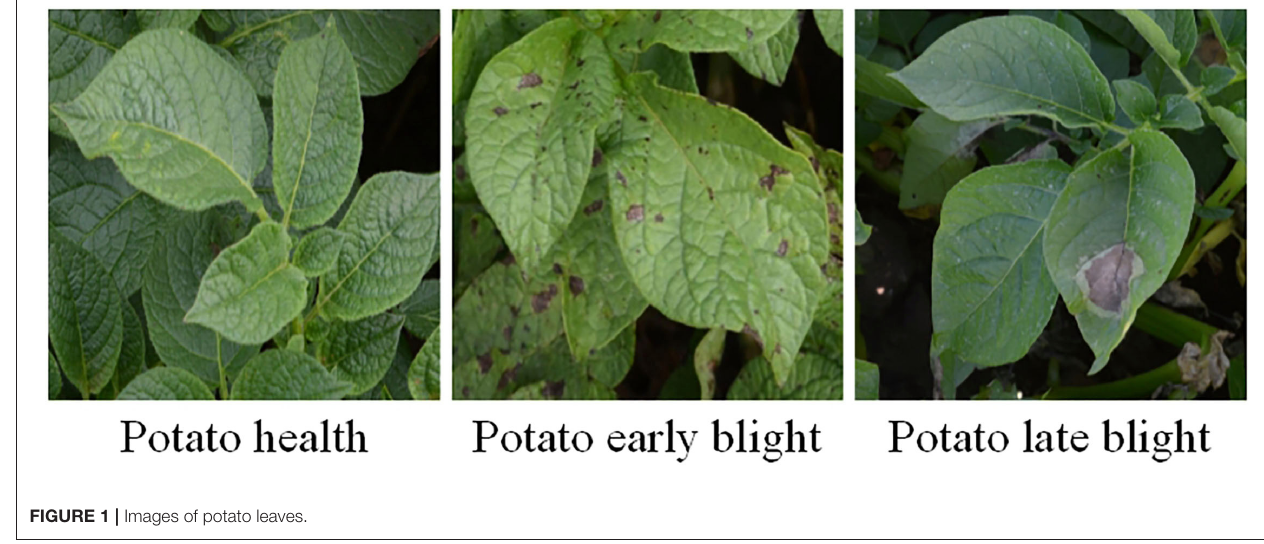
FIGURE 1 | Images of potato leaves.